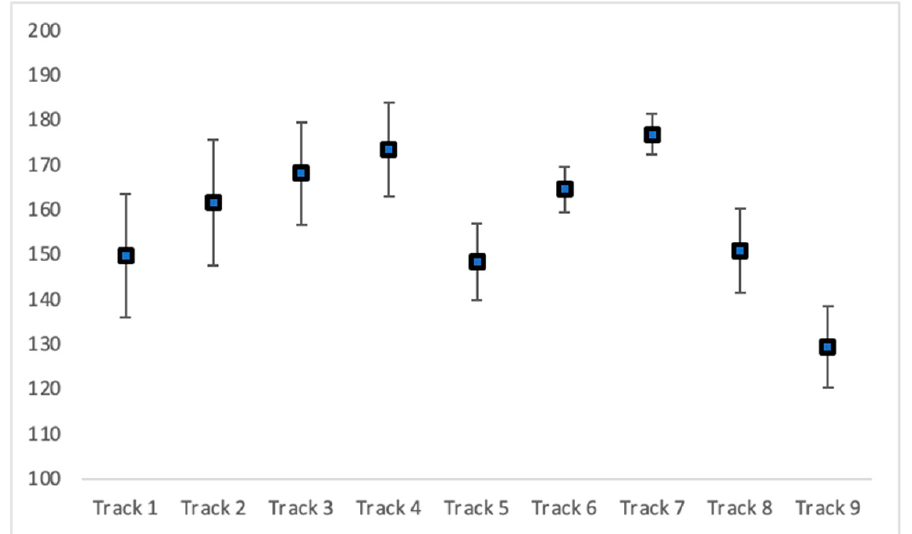
Figure 1. Average heart rate of the participants during Body Jump ® in each of the tracks. Table 3 shows the comparison between the pretests and the post-tests of both CG and BJ. Statistically significant increases were observed in the analyzed variables of physical condition in BJ. Thus, the VO 2Max ( p = 0.0001), the CMJ flight height ( p = 0.023), the SJ flight height ( p = 0.003) and the 1RM value in the uat exercise ( p = 0.009) improved statistically significantly in BJ. In CG, there were no statistically significant differences after the intervention period. Table 3. Pre- and post-test results of variables related to physical